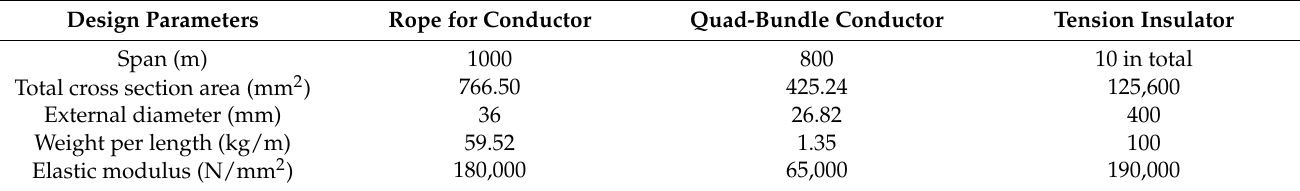
Table 1. Recommended design parameters of long-span CRS.